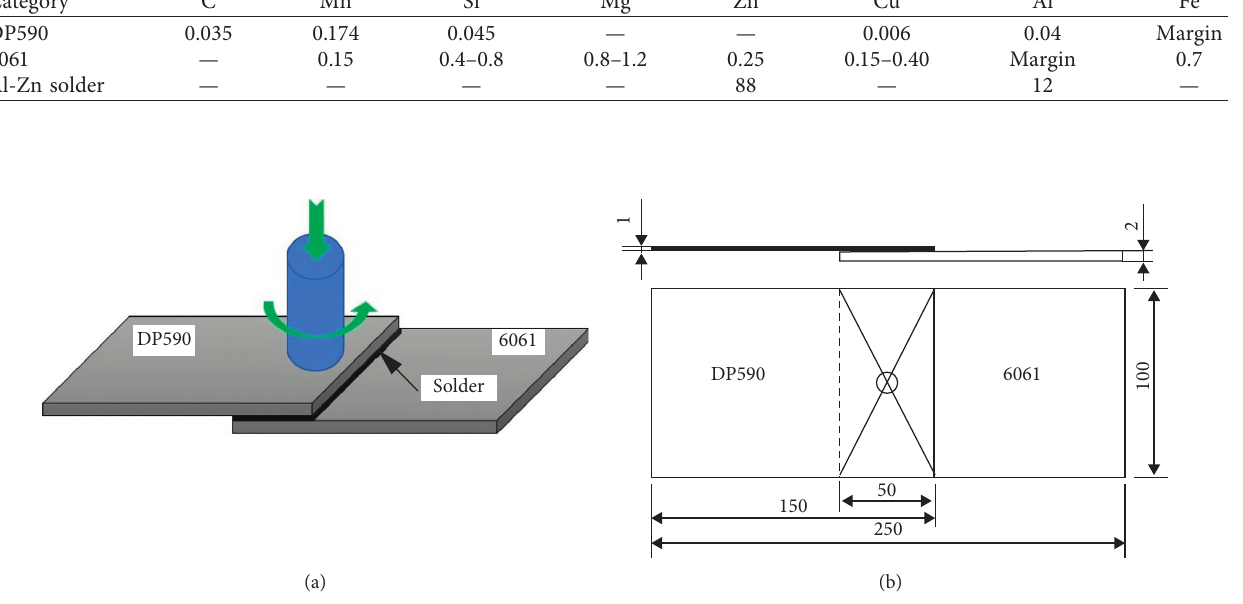
Figure 1: Welding joint scheme. (a) Lap joint. (b) The size of the lap joint.